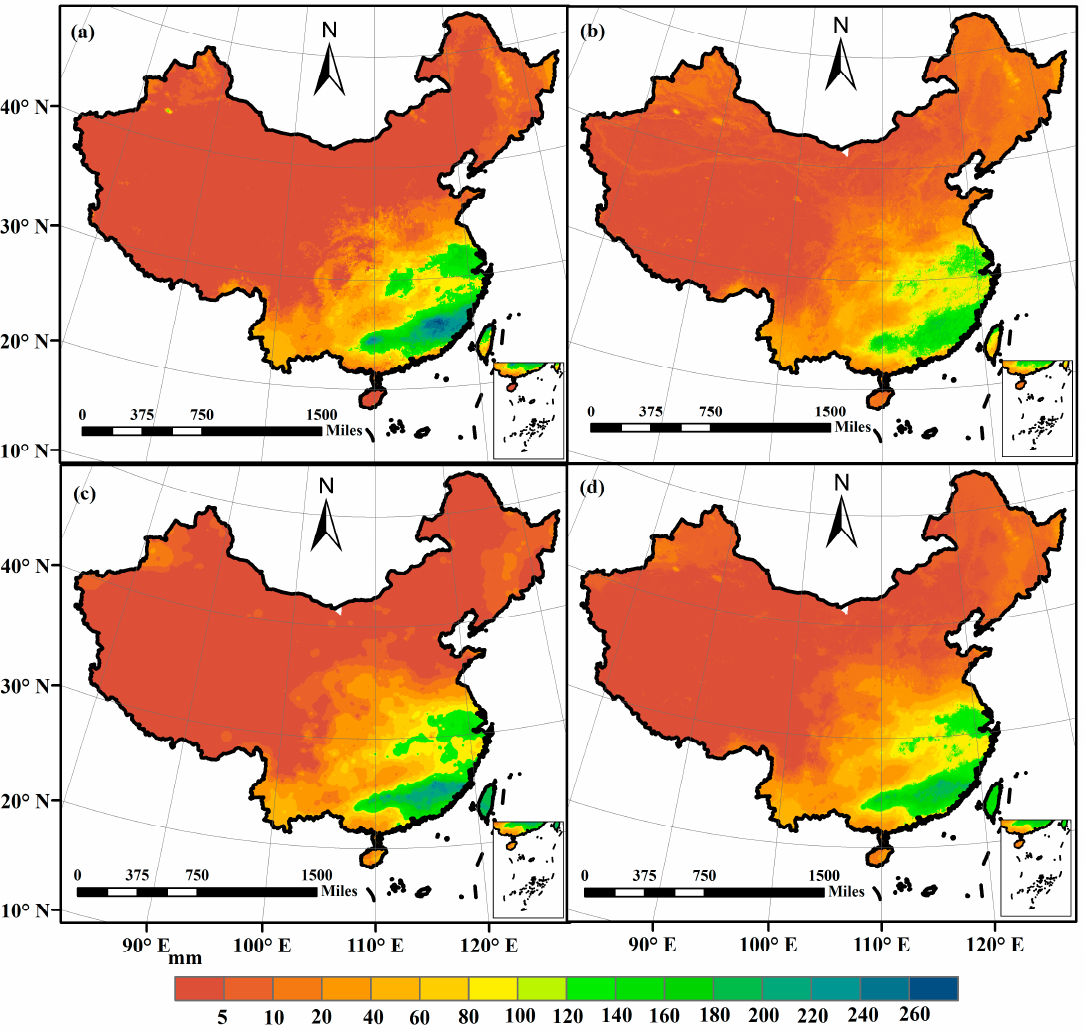
Figure 5. Precipitation estimates in January, 2018. ( a ) IMERG; ( b ) RF; ( c ) IDW; ( d ) The merging method.